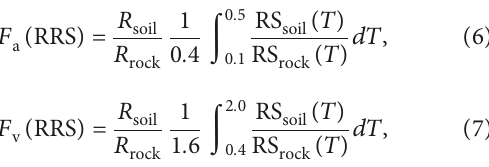
D sites with depth to bedrock: (a) 20.5m. (b) 32.0m. (c) 50.8m. (d)